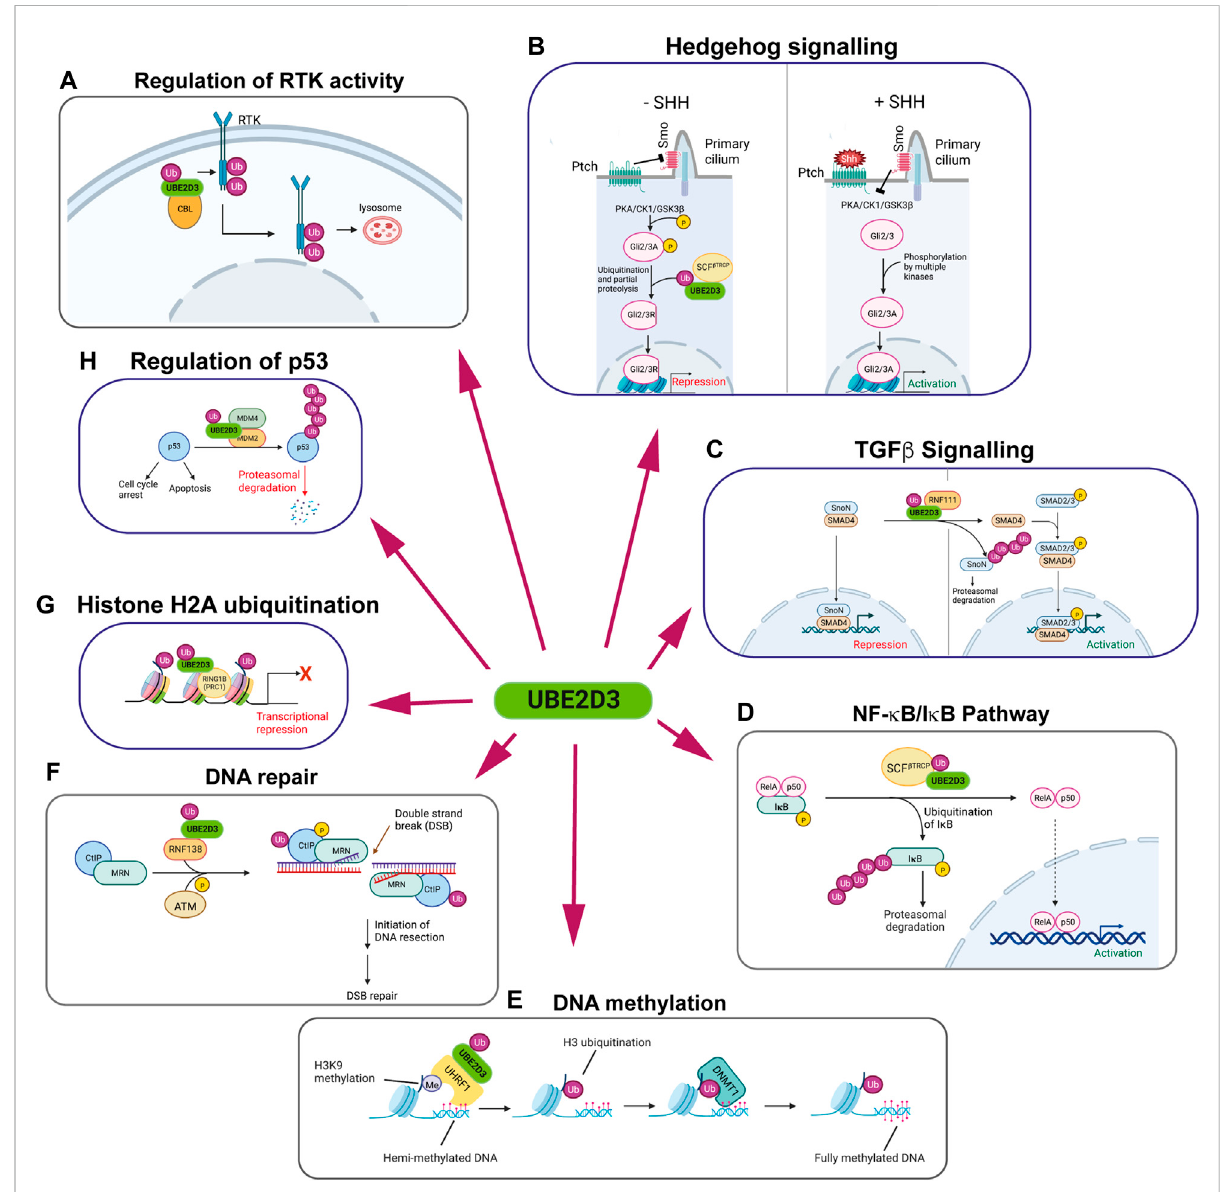
The multiple regulatory roles of the UBE2D enzymes. Panels show schematic representations of pathways that are regulated by UBE2D- mediatedubiquitination.UBE2D3isshown, asitisthemosthighly expressedoftheUBE2D enzymesinmammaliancells.Clockwisefromtopleft: (A) Regulation of receptor tyrosine kinase (RTK) activity: Monoubiquitination of RTKs by the E3 ligase CBL using UBE2D3 as a ubiquitin donor results in internalisation and traf fi cking to the lysosome, where the RTKs are degraded. (B) Hedgehog signalling: In vertebrates, absence of Sonic Hedgehog (SHH) allows the patch receptor (Ptch) to inhibit the Smo receptor, which is located in the primary cilium. Blocking Smo allows PKA, CK1 and GSK3 β to phosphorylate speci fi c residues on the Gli2/Gli3 transcription factors. Phosphorylation promotes ubiquitination of Gli2/3 by the E3ligaseSCF β TRCP inconjunctionwithUBE2D3,leadingtopartialproteolysisofGli2/3.ThisconvertsGli2/3torepressors(Gli2/3R).Increasedlevelsof SHH act on Ptch, blocking its effect on Smo and allowing it to inhibit PKA/CK1/GSK3 β . This opens Gli2/3 to phosphorylation by CK2, Akt and other kinases, converting them to their active forms (Gli2/3A) and leading to activation of SHH target genes. (C) TGF β signalling: Left: The repressor SnoN interacts with SMAD4 at target genes repressing their expression in the inner cell mass and developing epiblast cells of the mouse embryo. During primitive streak formation, the Ring fi nger E3 ligase RNF111 (Arkadia) interacts with the UBE2D enzymes to ubiquitinate SnoN1, targeting it for degradation and allowing activation of SMAD4 target genes. (D) NF- κ B/I κ B pathway: I κ B forms an inhibitory complex with the NF- κ B subunits RelA and p50. Phosphorylation of I κ B promotes its ubiquitination by the E3 ligase RNF138 in conjunction with UBE2D3, leading to proteasomal degradation of IkB and activation of NF- κ B target genes. (E) DNA methylation: Maintenance methylation of hemi-methylated DNA is promoted by bindingoftheE3ligaseUHRF1todi-andtri-methylatedH3K9.UHRF1actsinconjunctionwithUBE2D3tomonoubiquitinateH3atK14,K18,K23and K27. The ubiquitinated H3 residues bind DNMT1, leading to methylation of the unmethylated DNA strand. (F) DNA repair: The ring fi nger E3 ligase RNF138 ubiquitinates the N-terminal region of the DNA repair protein CTiP using the UBE2D proteins as ubiquitin donors. N-terminal